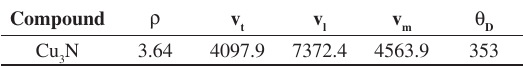
Table 4. The calculated density ( r , in g/cm 3 ), longitudinal, transverse and average sound velocity